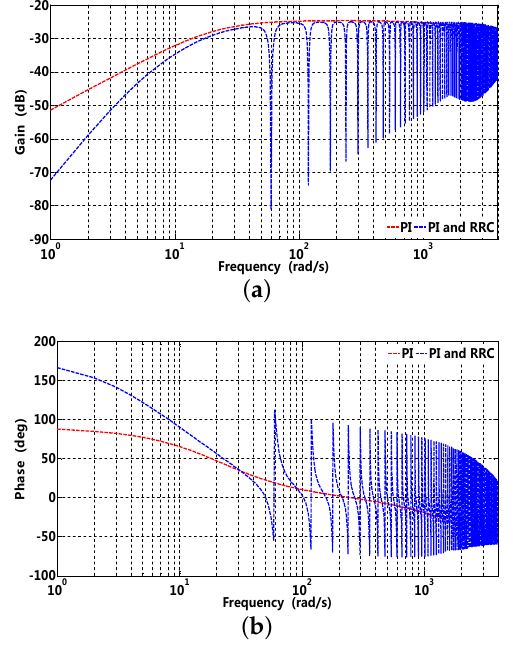
Figure 10. Gain and phase waveforms of q -axis current sensitivity function, where corresponding parameters are N = 1044, ω 0 = 60 rad/s, K q = 0.6, p = 3, D = 2.6 and T s = 0.1 ms, respectively. ( a ) gain; ( b )